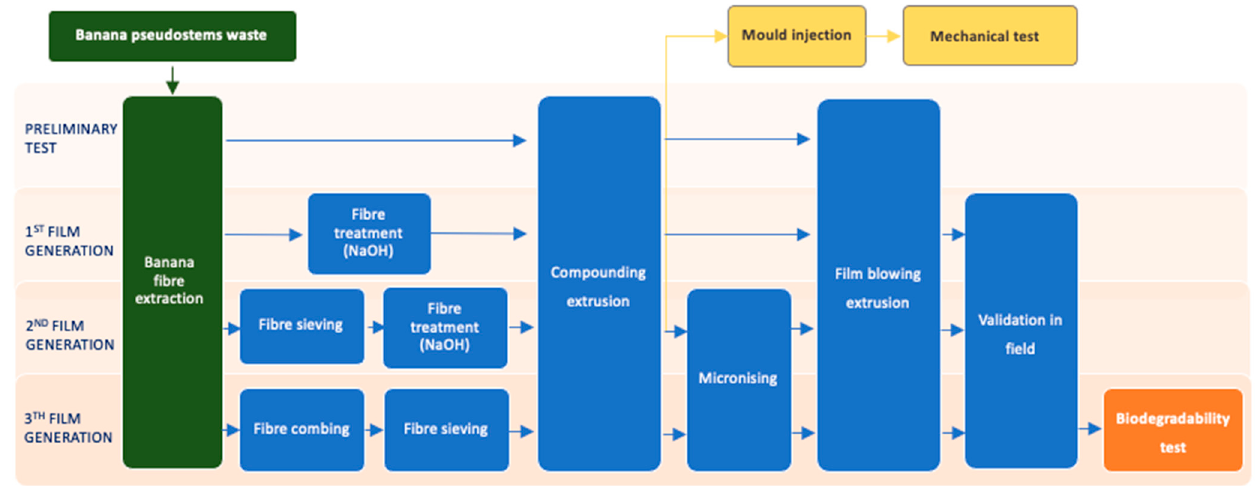
Figure 1. Fiber treatment and manufacturing process diagram.